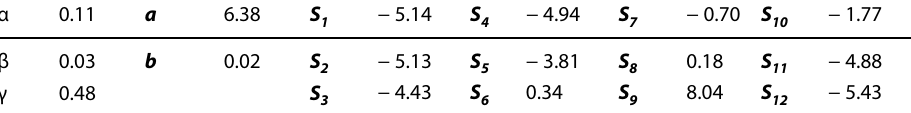
Table 5 Estimated parameters for Holt–Winters model